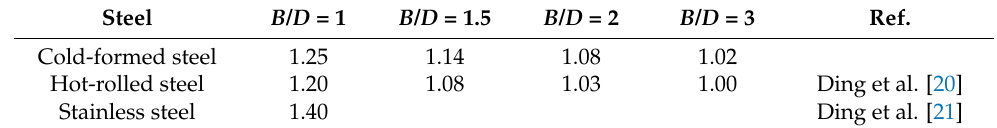
Table 4. Comparison of K of CFST stub columns with different steel types.